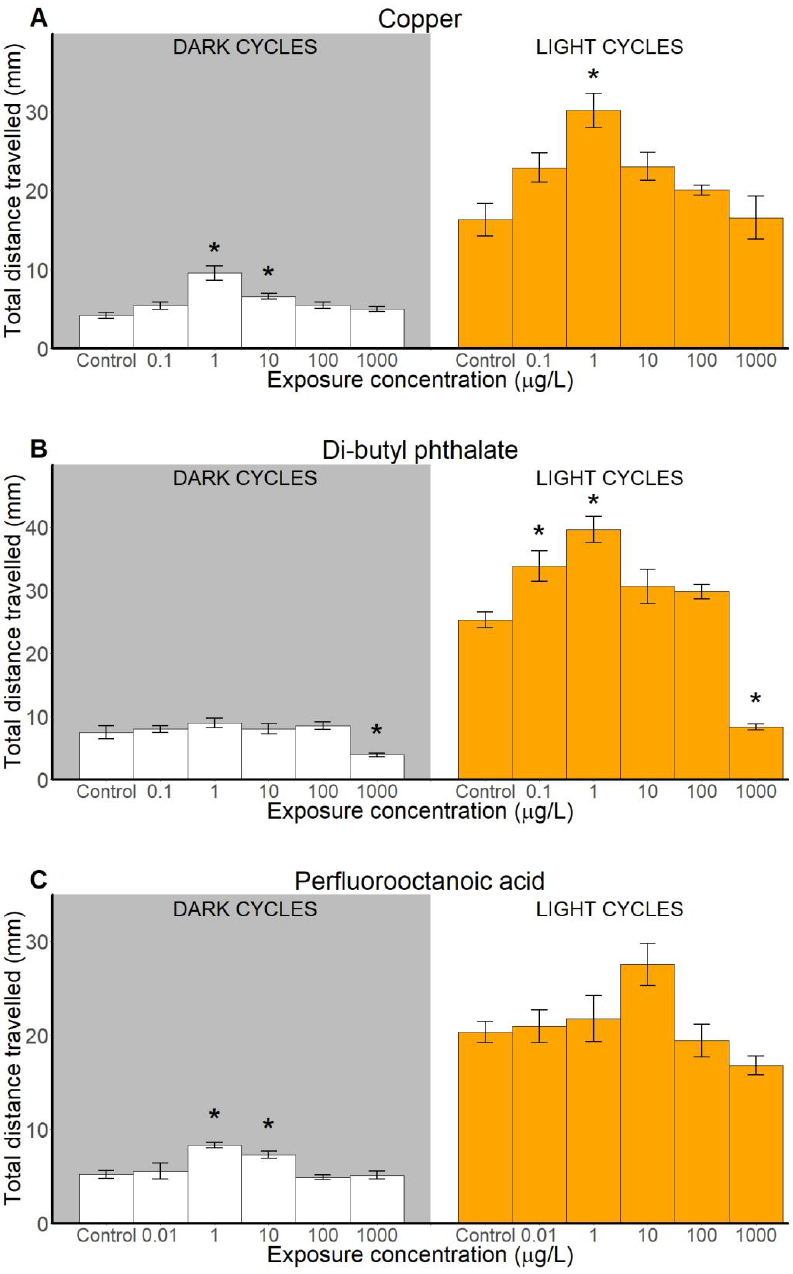
Figure 4. Locomotive distance (measured as distance travelled) of sand goby larvae exposed to copper ( A ), di-butyl phthalate ( B ), and perfluorooctanoic acid ( C ). Results presented as means ± SEM for dark (left) and light (right) cycles. Statistically significant differences ( p < 0.05) between control and other treatments are indicated with asterisks (*), ( n ≥ 31 ).